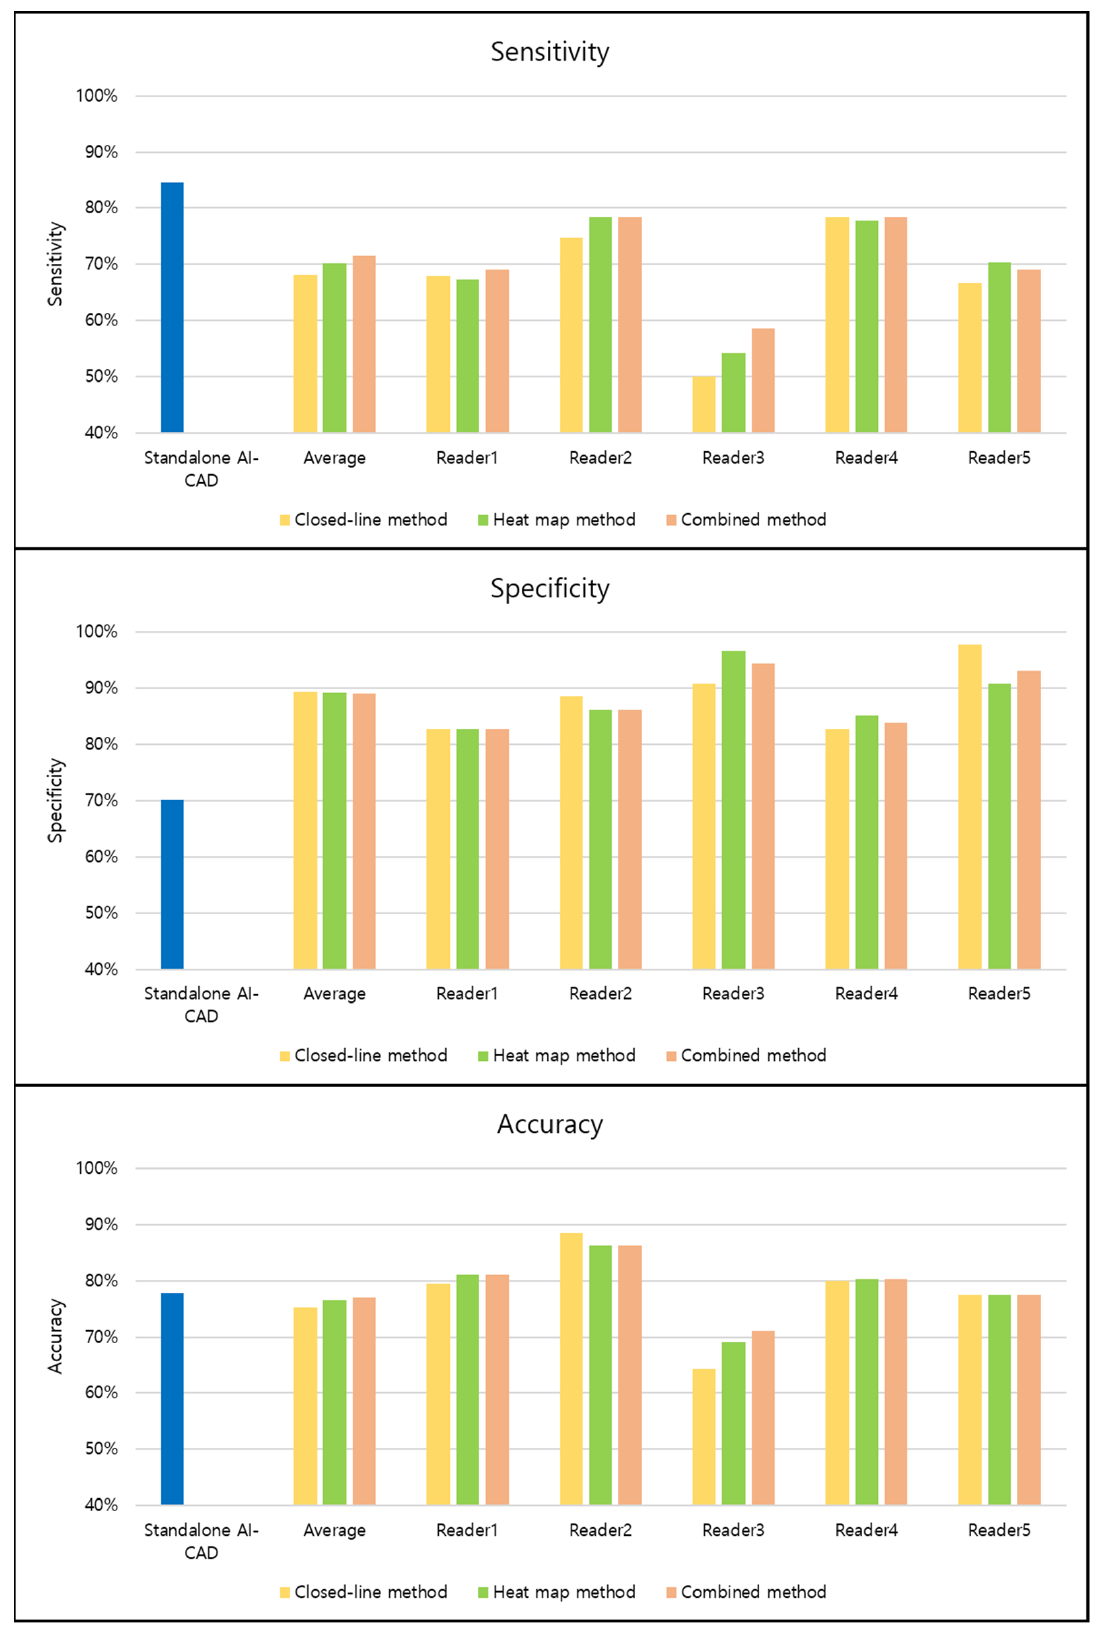
Figure 3. Accuracy of interpretation of individual readers, and stand-alone AI-CAD.